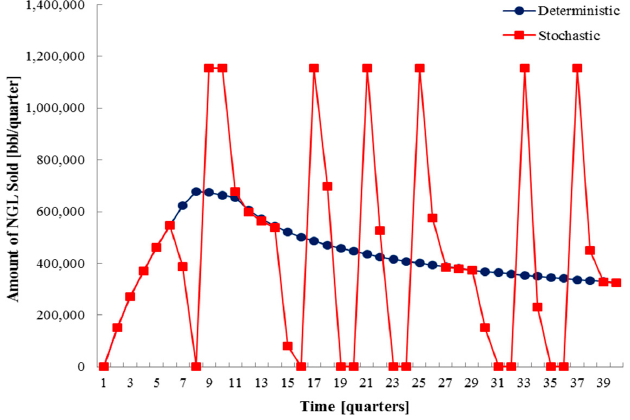
Figure 10. Comparison of sold NGL during the planning horizon for stochastic and deterministic cases studies. Energies 2017 , 10 , 246